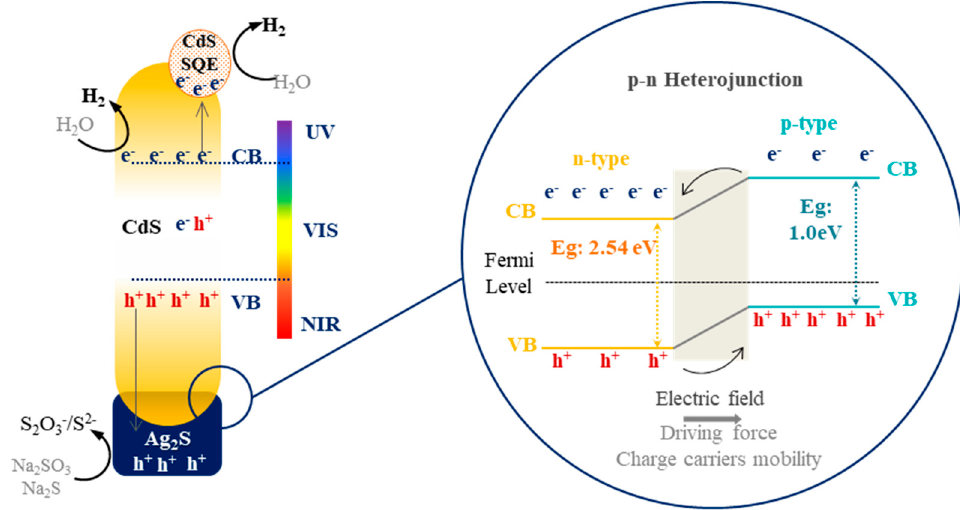
Figure 10. Schematic diagram showing the combination of factors that operates in the AgCdS-T